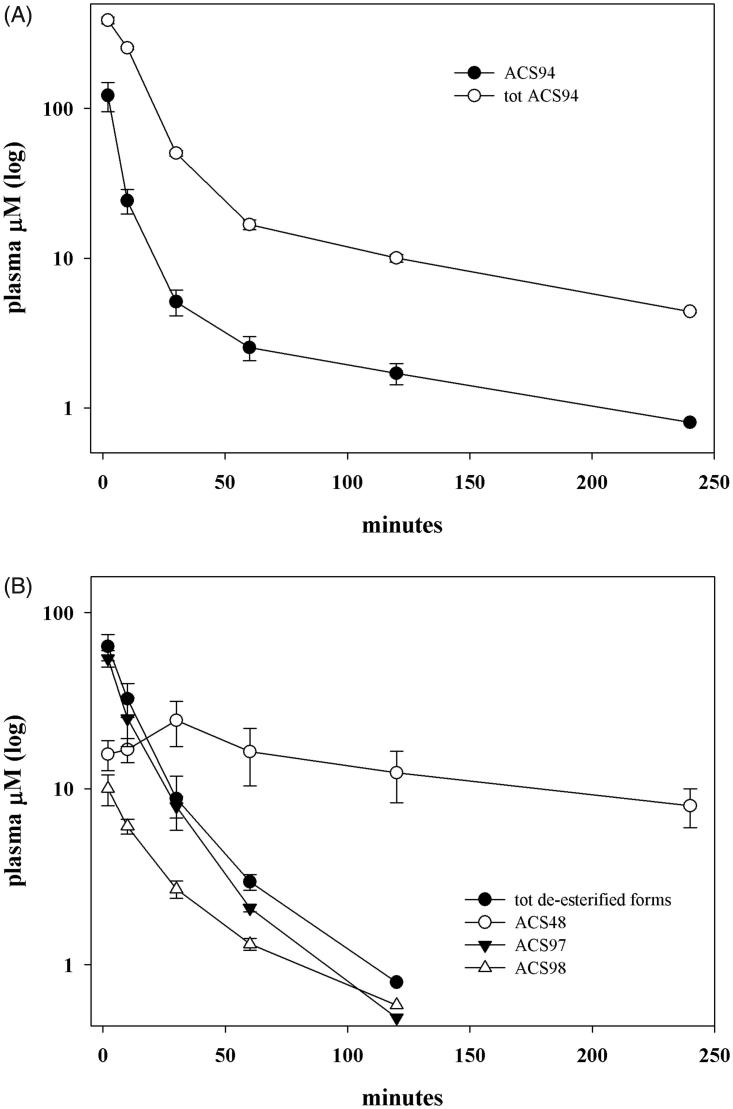
ACS94 metabolism. Plasma levels of ACS94 and its metabolites after the iv administration of 20 mg/kg to rats. Times of analysis are: 2′, 10′, 30′, 60, 120′, 240′. Data are the mean ± SD; n = 3. (A) tot ACS94= ACS94 + 2x ACS96 + ACS99 + 1/2 ACS94-Cys; (B) tot de-esterified forms: ACS98 + 2xACS97 + 1/2 ACS99.